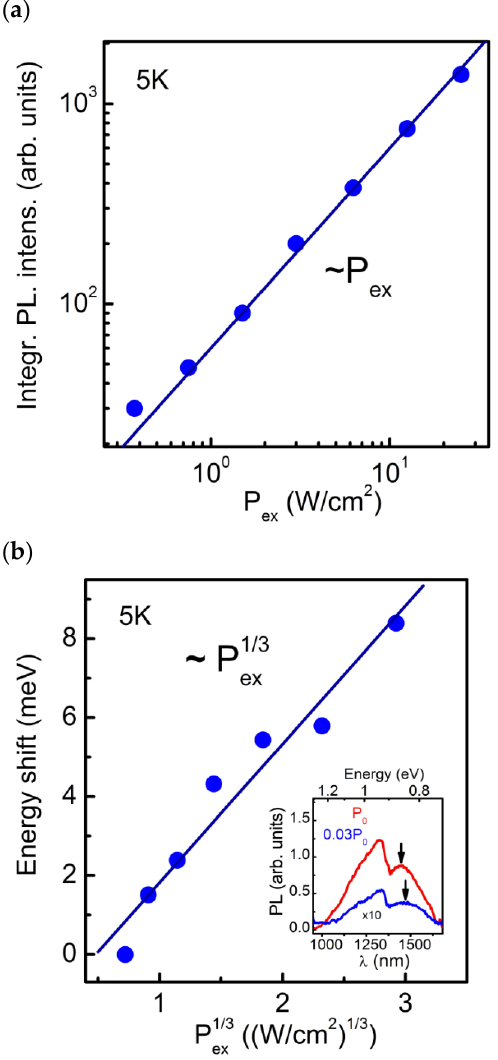
Figure 8. ( a ) Dependence of the integral SAQD PL intensity on P ex . The measurements were carried out at a temperature of 5 K. The solid line shows the approximation of the experimental data by the ~ P ex law. ( b ) The energy shift in the SAQD PL band as a function of P ex . The solid line shows the approximation by the law ~ P ex1/3 . In the inset are the PL spectra of HS D measured at P ex = 25 W/cm 2 (red curve) and P ex = 0.75 W/cm 2 (blue curve). The arrows mark the positions of the SAQDs PL band maxima.